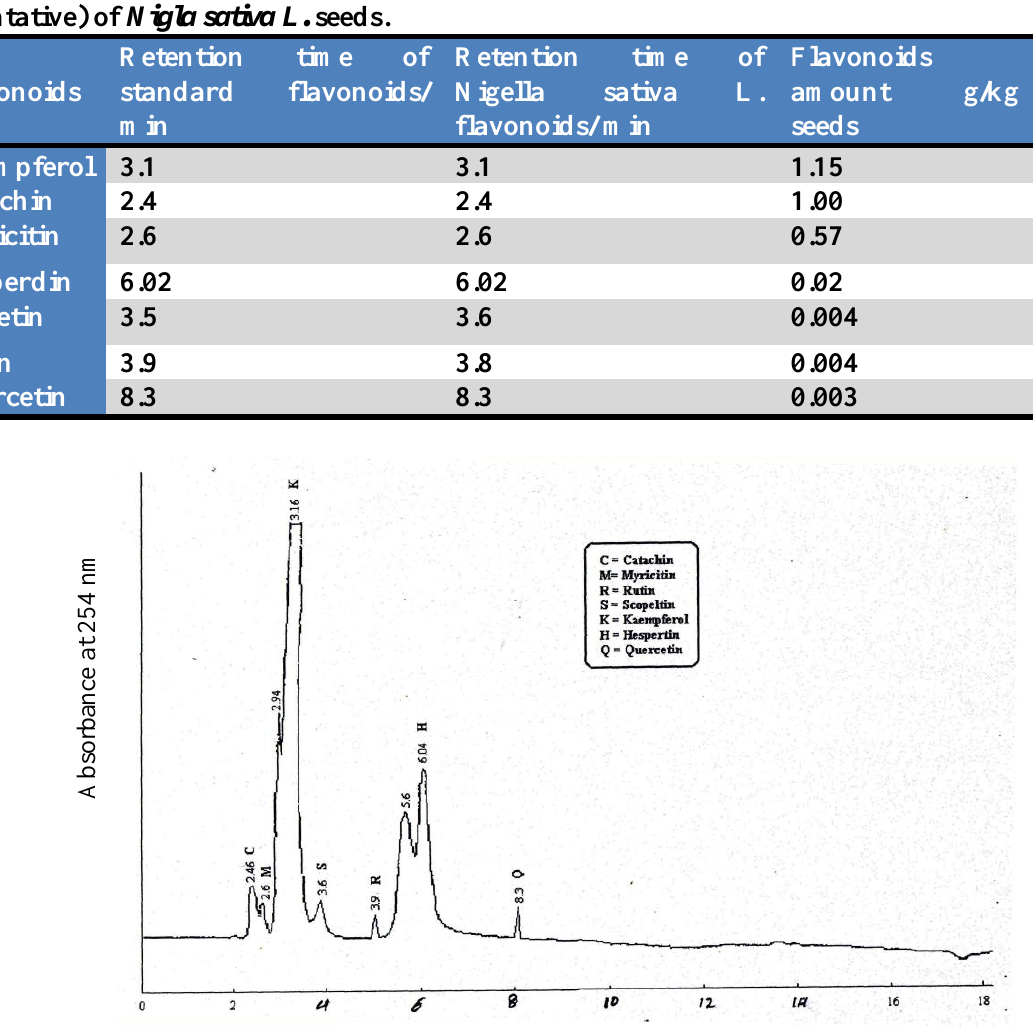
Retention time (min.) Figure1: High performance liquid chromatography standard of Black Cumin flavonoids.